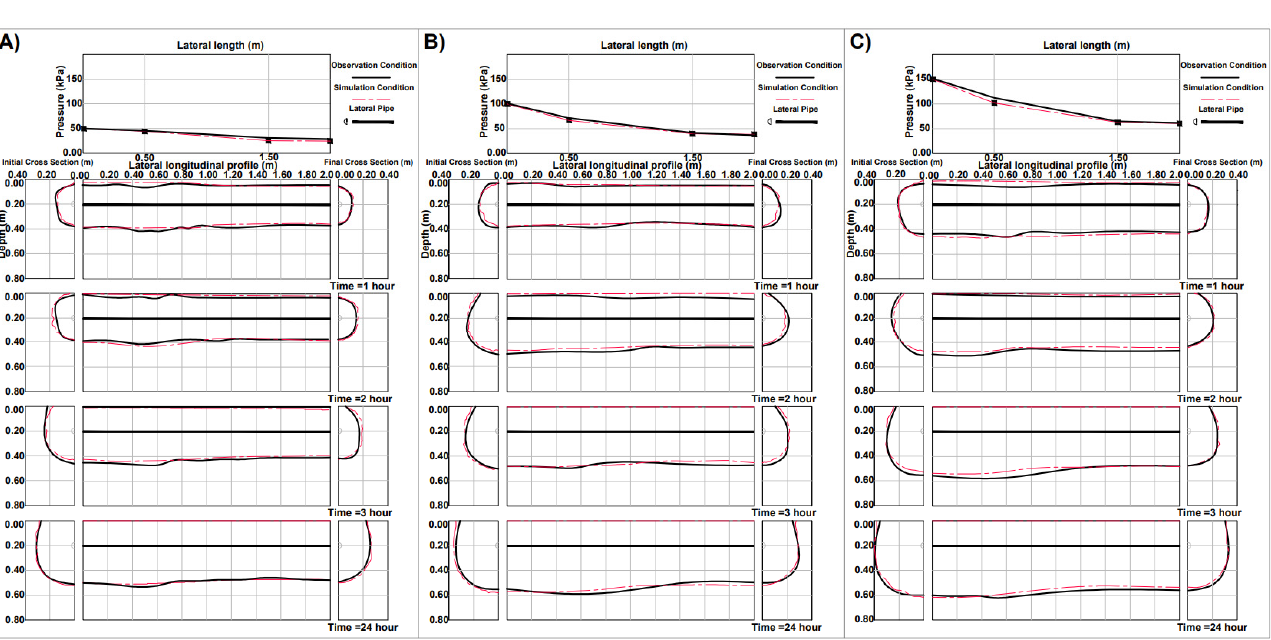
Figure 5. Comparison between observed and simulated wetting fronts for drip lateral with 20 cm emitter spacing at operating pressures of ( A ) 50 kPa, ( B ) 100 kPa, and ( C ) 150 kPa.